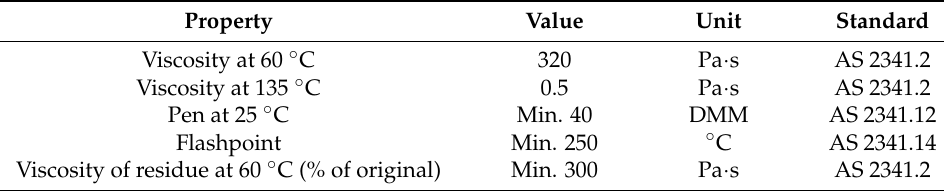
Table 1. Bitumen Class 320 properties Reprinted from ref.